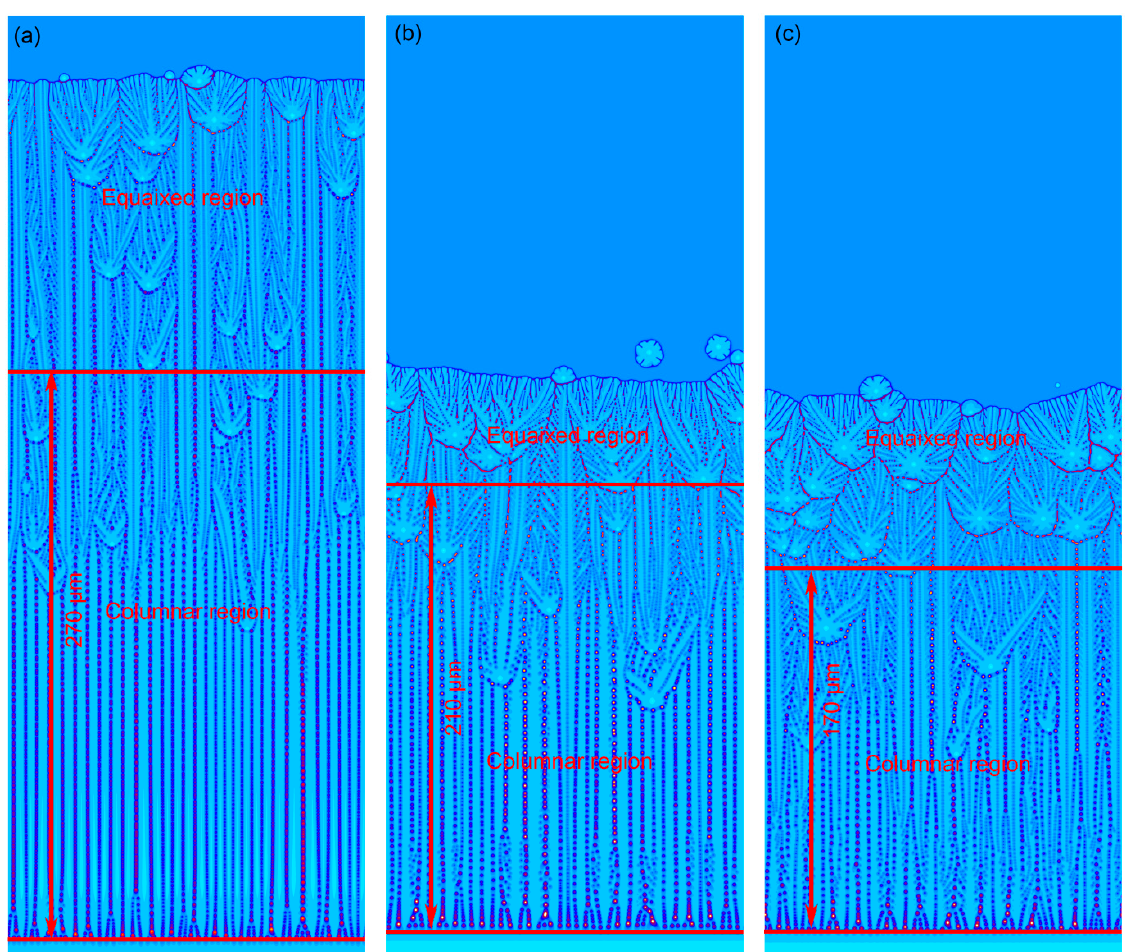
Figure 13. Predicted microstructure under transient thermal conditions at different locations in the fusion zone of laser weld: ( a ) upper (Region I), ( b ) middle (Region II), and ( c ) bottom (Region III).